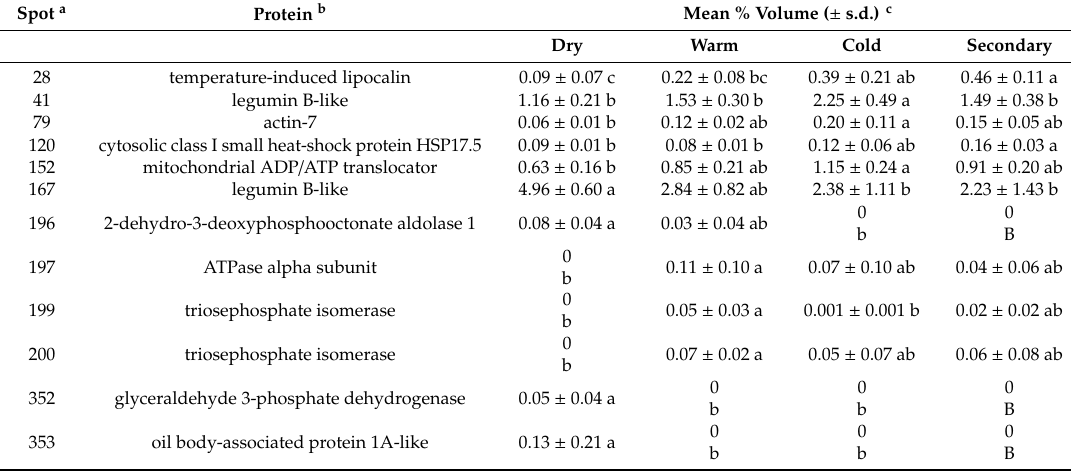
Table 2. The abundance of identified proteins of Rosa canina L. seed that significantly changed during primary dormancy release by warm (25 ◦ C) and cold (3 ◦ C) stratification and secondary dormancy induction by warm treatment (20 ◦